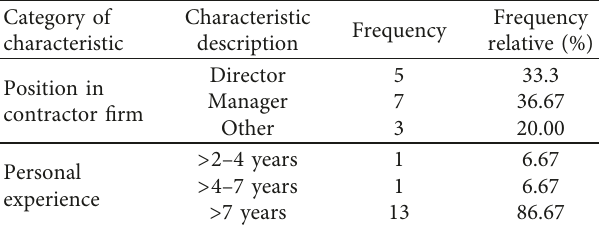
Table 6: Result of the validity test of FI data.